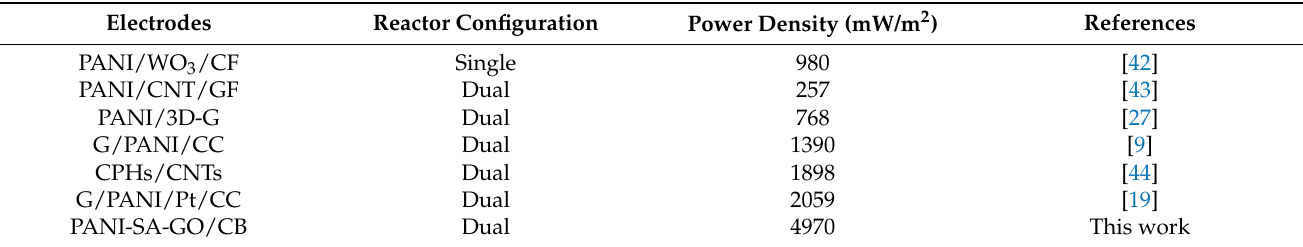
Table 1. Comparison of the power density in both double-chamber (the schematic diagram of double-chamber MFC structure is shown in supporting information Figure S2) and single-chamber MFCs with di ff erent anode materials.